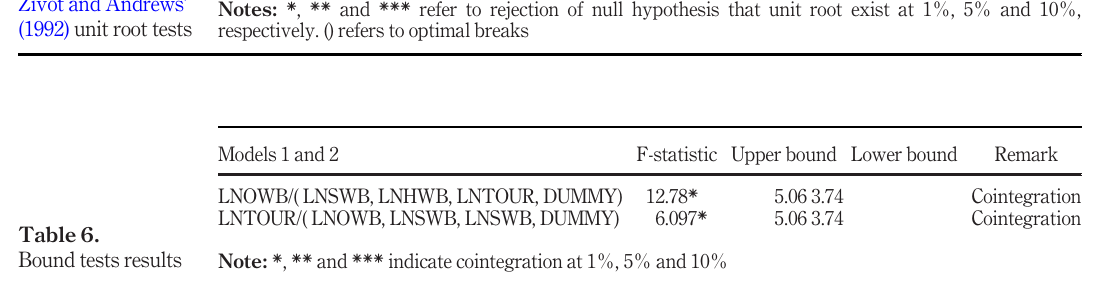
Table 6. Bound tests results